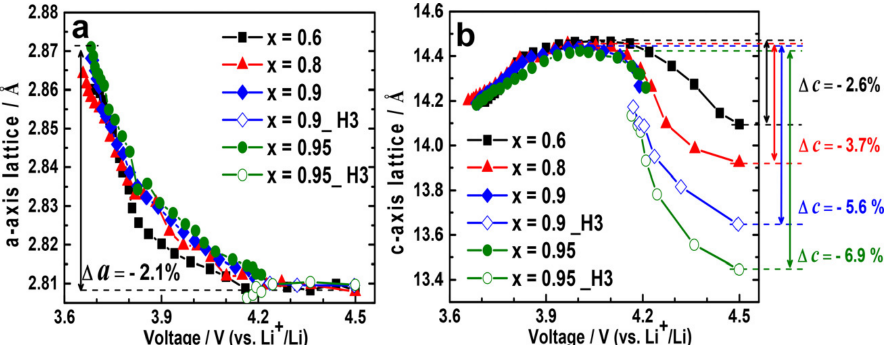
Figure 25. ( a ) a -axis and ( b ) c -axis lattice parameters of Li[NixCoyMn 1–x–y ]O 2 as a function of the Ni content ( x = 0.95, x = 0.9, x = 0.8 and x = 0.6) and the cell voltage. Reprinted with permission of [106], ©2018 American Chemical